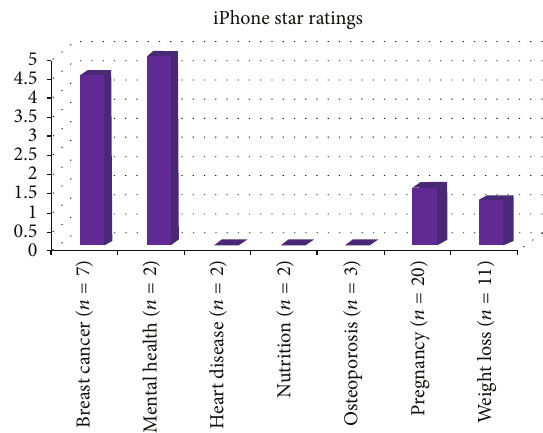
Figure 3: Average star ratings. Note: star ratings were not recorded for the heart disease, nutrition, or osteoporosis apps.